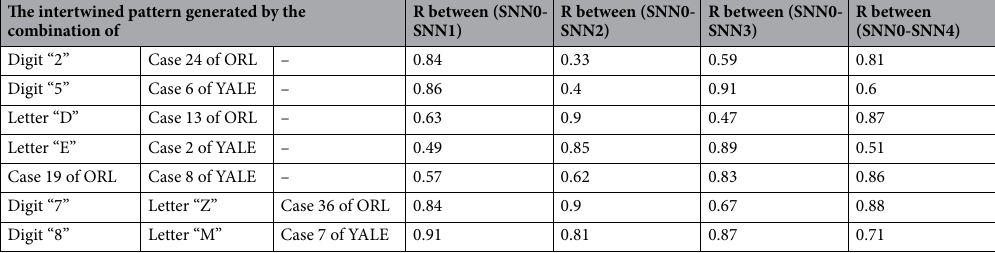
Table 5. The synchronization criterion R when the input of Fig. 8 was excited with the different intertwined patterns.